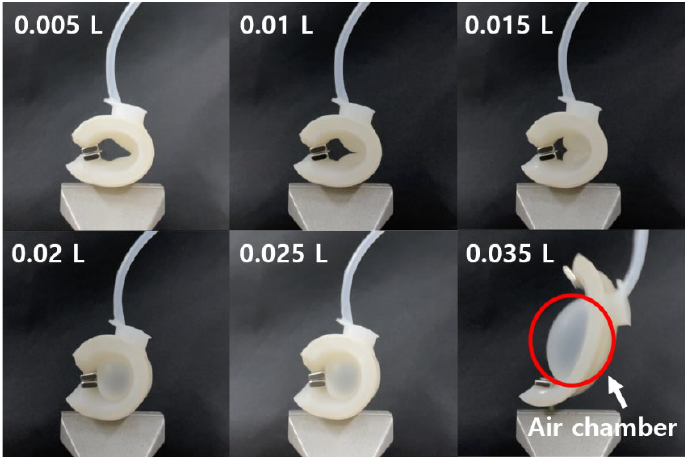
Figure 11. Pulling force of magnet according to distance.